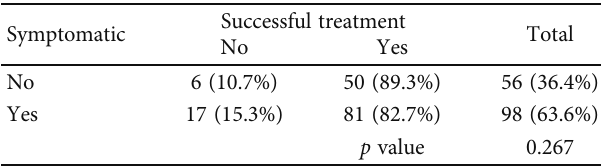
Table 2: Symptomatic vs. asymptomatic comparison with successful treatment using the chi-squared